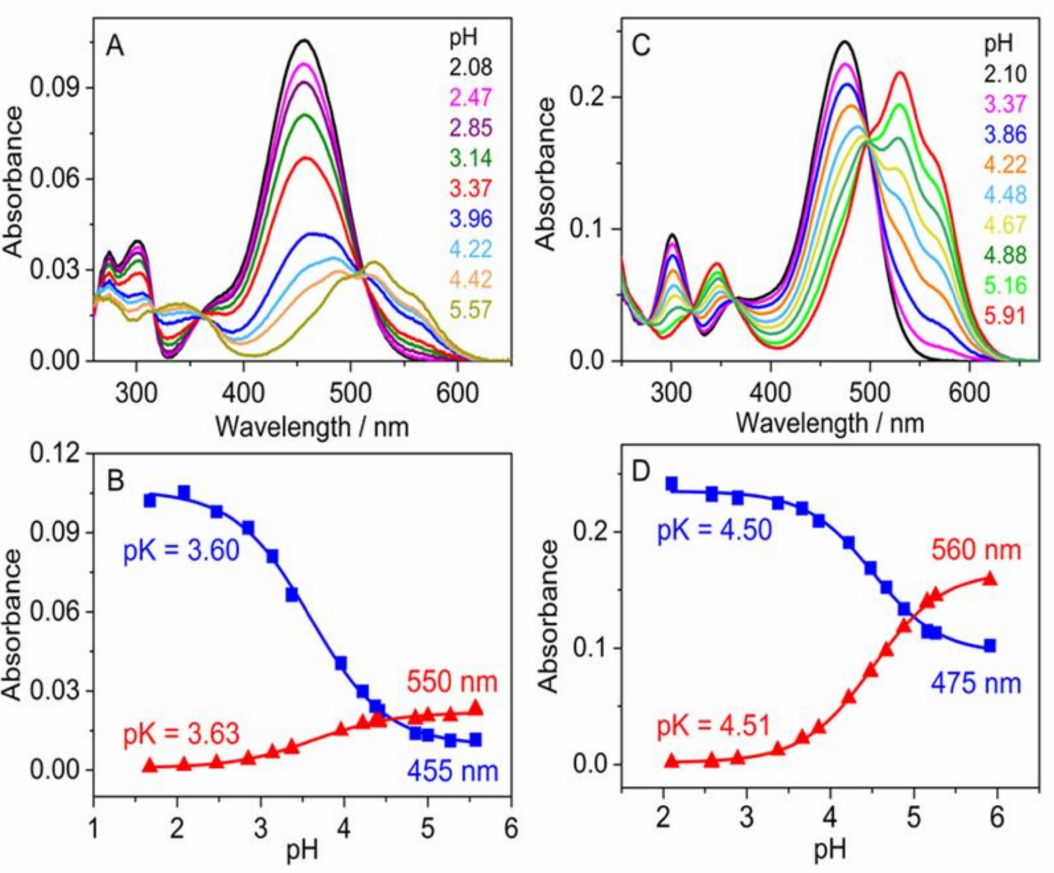
Figure 8. Effect of pH variation on the absorption spectrum of 7 ( A ) and 5 ( C ) in water. Absorbance of 7 ( B ) and 5 ( D ) solutions at two wavelengths as a function of pH. Measurements were performed immediately after pH